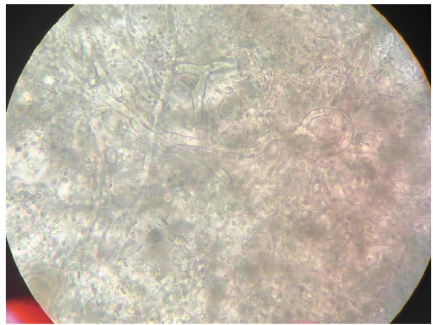
Figure 4: Fungal culture showing broad aseptate hyphae with sporangiophores arising from nodes above the rhizoids suggestive of Rhizopus